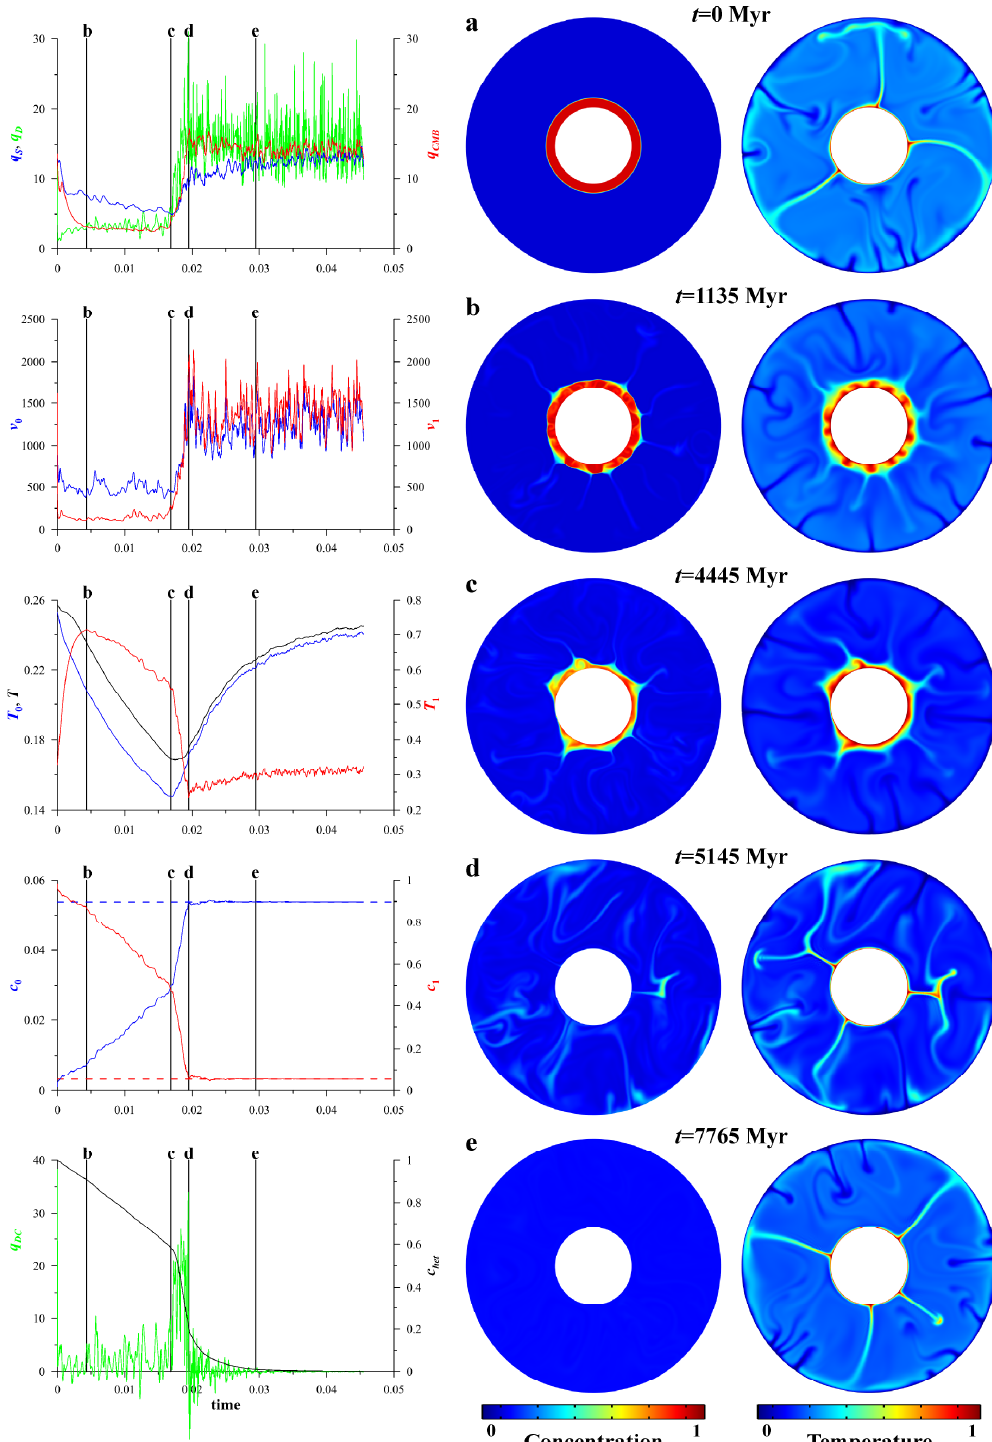
Figure 1. Five stages characterizing the evolution of the thermo-chemical convection as a funktion of non-dimensional time. Left: time series of monitoring parameters (heat flux, velocity, temperature, concentration, see in Table 2), vertical lines denote the stages shown in the right side. Right: the evolution of the concentration of the dense material and the temperature